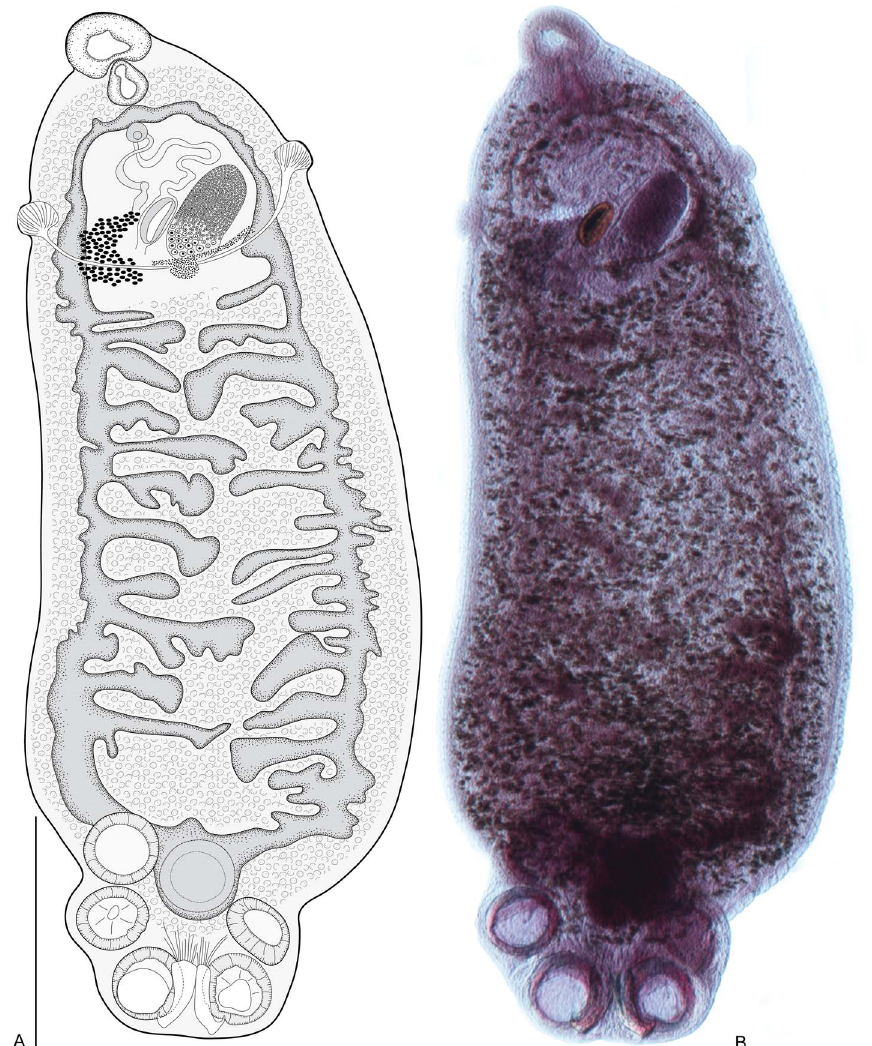
Figure 7. Indopolystoma parvum n. gen. n. sp. from Zhangixalus omeimontis . Dorsal view of holotype. (A) A drawing; (B) A photograph. Scale bar: 1